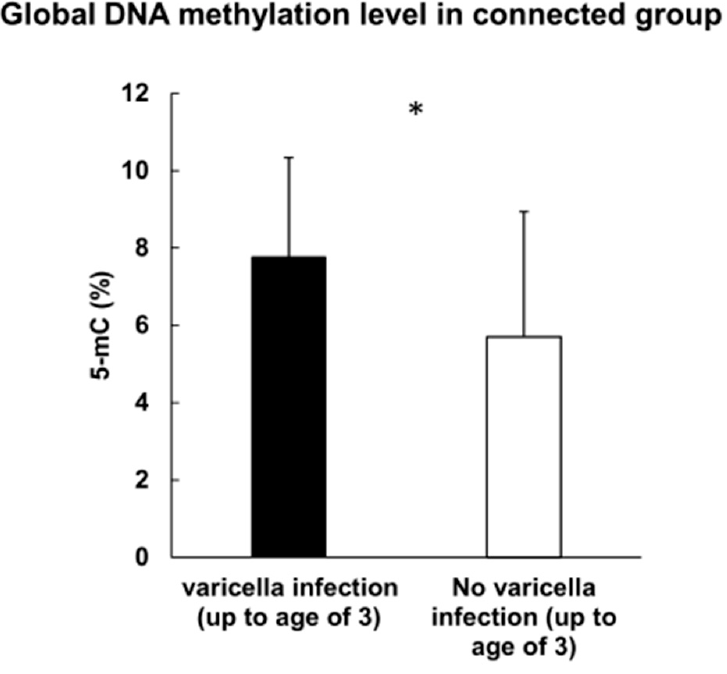
Figure 6. Global methylation level and varicella infection in the total group; *—statistically signifi ‐ cant.